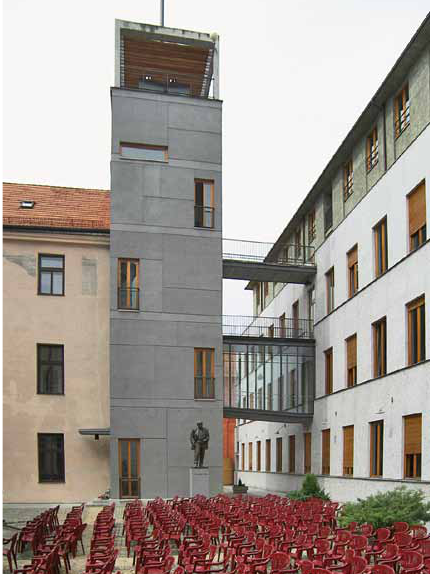
fig. 3. Šrámková architekti: new bridge in Přerov, 2012. P. Kratochvíl photo